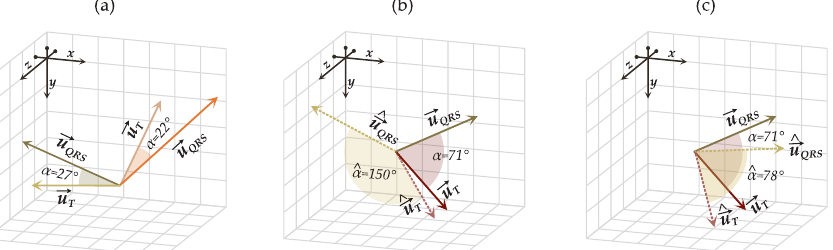
#» #» u QRS and u T located in two different #» #» u T ) but not the other ( u QRS ), yielding large errors in the